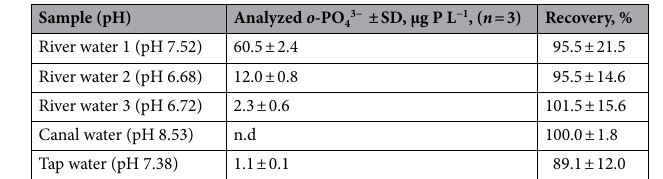
Table 3. Analyzed concentrations and recovery percentages of o -PO 43− in water samples. n.d.: not detectable (< LOD 0.3 µg P L −1